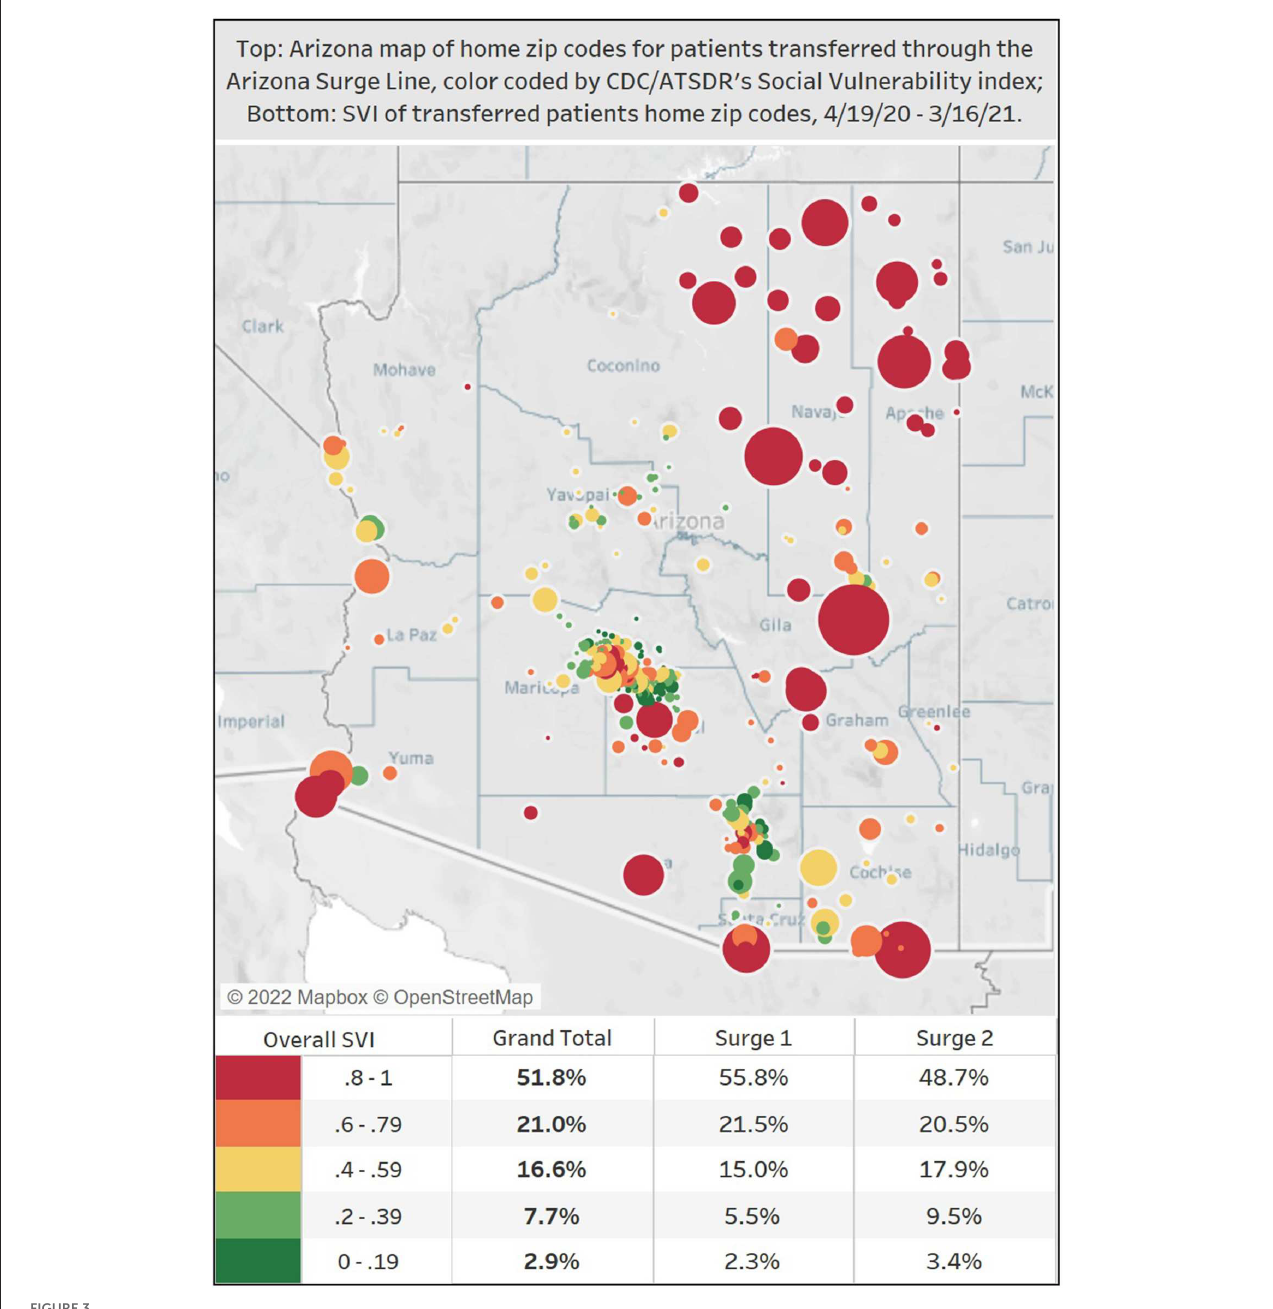
FIGURE3 Map of home zip codes for transferred patients through the Arizona Surge Line (4/19/20–3/16/21), color-coded by CDC/ATSDR’s Social Vulnerability Index. On this map of Arizona, the colors reflect the levels of the CDC/ATSDR social vulnerability index, with red and orange indicating the top two quintiles indicating greater vulnerability. The circles represent an ASL transferred patient’s home zip code, and the larger the circle, the larger the transfer volume from that particular zip code. Zip codes with the highest vulnerabilities were the points of origin for 73% of ASL’s transferred